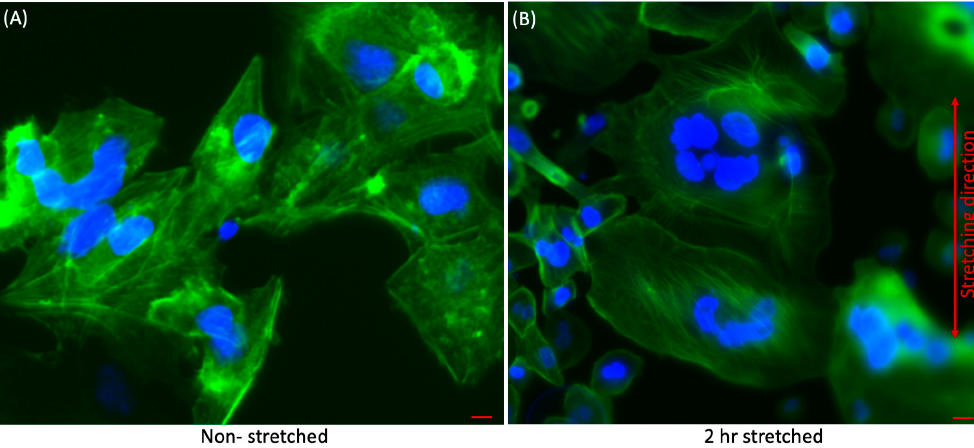
Figure 2. Representative fluorescence images of ( A ) Non-stretched ( B ) 2 h stretched HepG2 cells presenting the morphology and distribution of cells after stretching for 2 h compared with non-stretched cells. ActinGreen (green) labels cellular actin, and Nucblue (blue) stains nuclei ( × 20). As a result of the mechanical stimulations, the actin stress fibres of the stretched cells gradually reconstructed. Accordingly, the cytoskeleton architecture of the stretched cells was reorganized over time. Both scale bars in the figure are 50 µm.